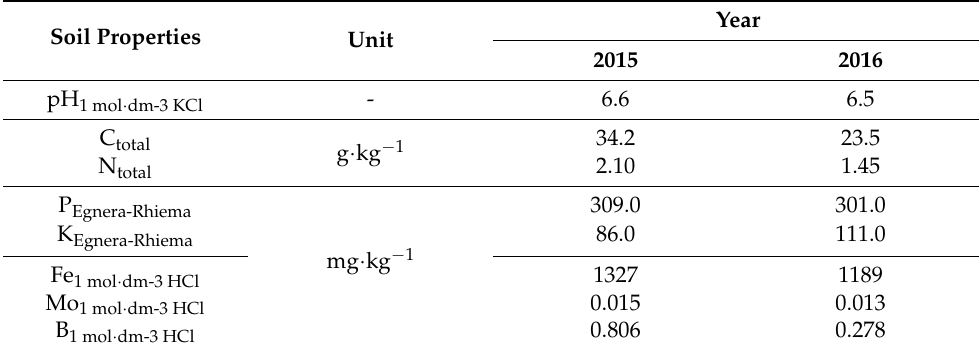
Table 1. Some properties of soil in the layer 0–0.25 m before foundation of experiment in 2015 and 2016. Soil